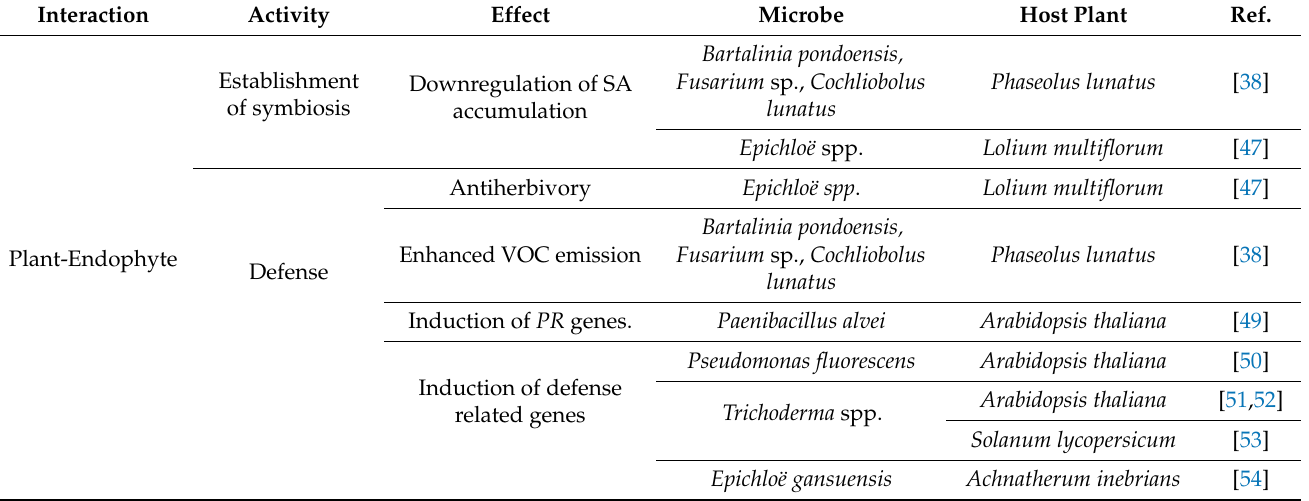
Table 1. Involvement of salicylic acid in plant–microorganism symbiotic interactions and de- fense